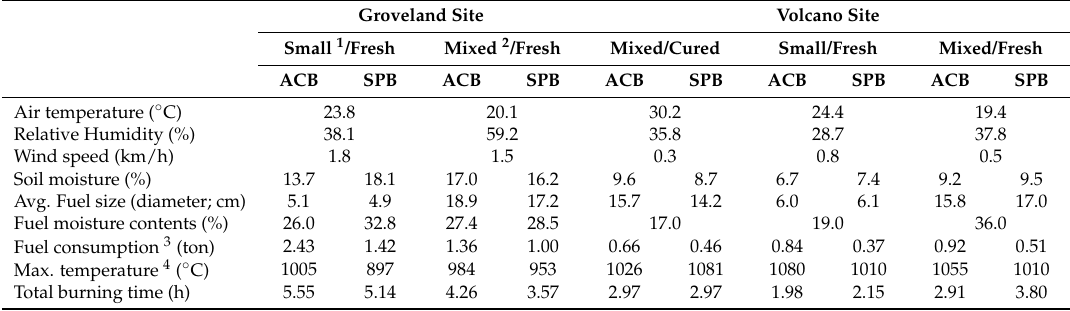
Figure 1. ( a ) Air curtain burner with ember case; and ( b ) slash pile burning (Photo credit: H.-S. Han). Table 1. Description of climatic and fuel conditions for slash pile burning (SPB) and air curtain burner